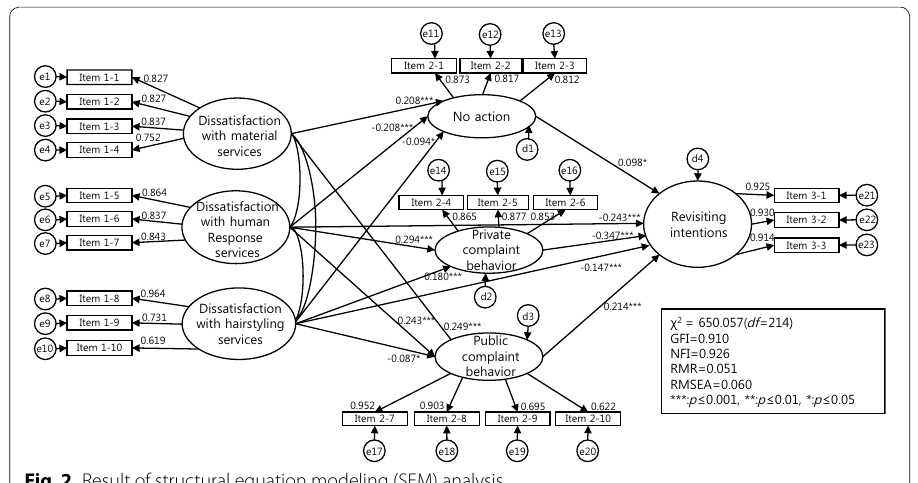
Fig. 2 Result of structural equation modeling (SEM)